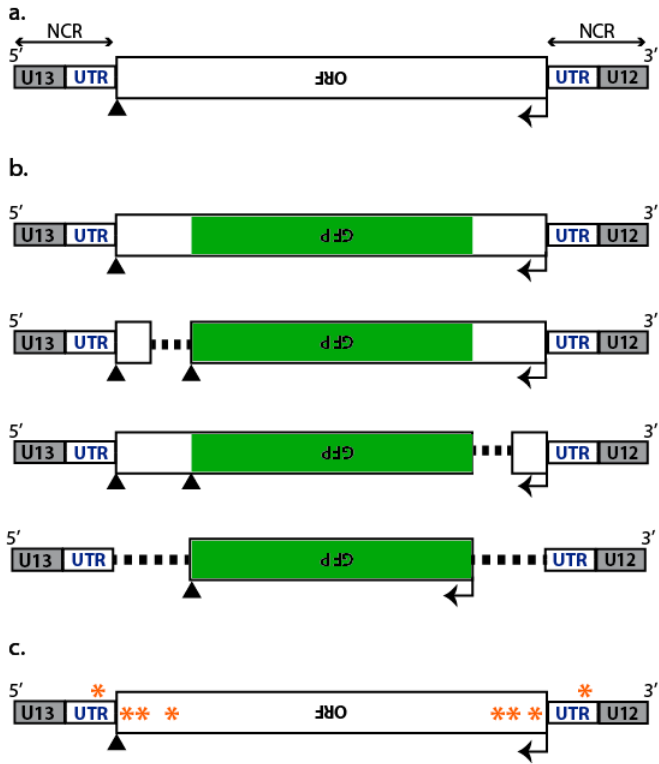
Figure 1. Schematic diagram of influenza A viral RNA segments (vRNAs). ( a ) Genetic organization of the influenza A virus (IAV) genomic segments. Each segment contains at least one open reading frame (ORF) in antisense orientation, flanked by segment specific non-coding regions (NCRs) encompassing untranslated regions (UTR) and conserved unique (U) promoter regions of 12 (U12) and 13 (U13)-nucleotides (nt) long; ( b ) Schematic diagram of green fluorescent protein (GFP)-reporter vRNAs. The center portion of the coding region is replaced with the GFP coding region (green), flanked by portions of various lengths of the corresponding termini of the coding region of interest (white); ( c ) Schematic representation of vRNAs bearing synonymous mutations (orange asterisks) introduced into the NCRs and termini of the coding regions. Initiation and stop codons are indicated by arrows and triangles, respectively.